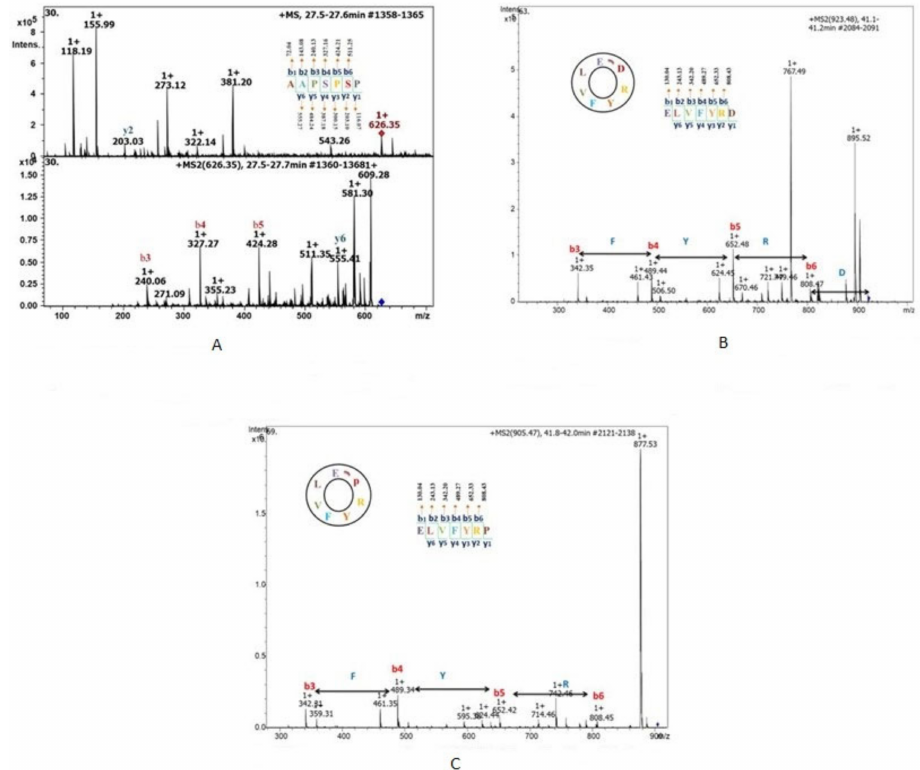
Figure 2. Denovo sequencing of ( A ) linear peptide SA626 from the daughter ions derived from fragmentation of singly charged (M+H) 626.35 and ( B ) cyclic peptides SA 923.4 and ( C ) SA 905.4 from the daughter ions derived from fragmentation of singly charged (M+H) 923.4 and 905 respectively.